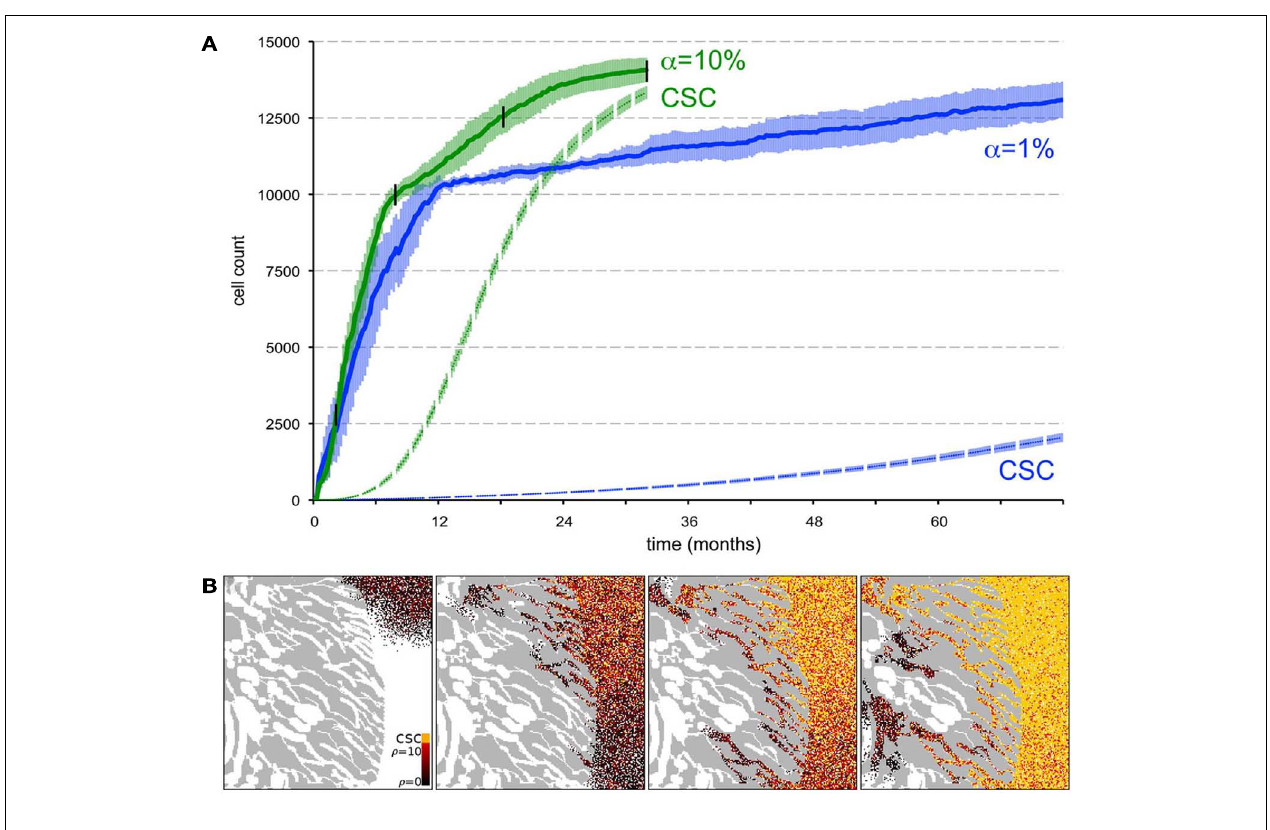
averages and standard deviations of 10 independent simulations. (B) Snapshots of different time points of tumor growth and invasion in a tumor with α = 10%.The time points are marked in (A) with black vertical = 10% lines.The stem cell pool in the tumor adjacent to the muscle increases s rapidly over time as non-stem daughter cells die off quickly compared to α = 1% in Figure 5G